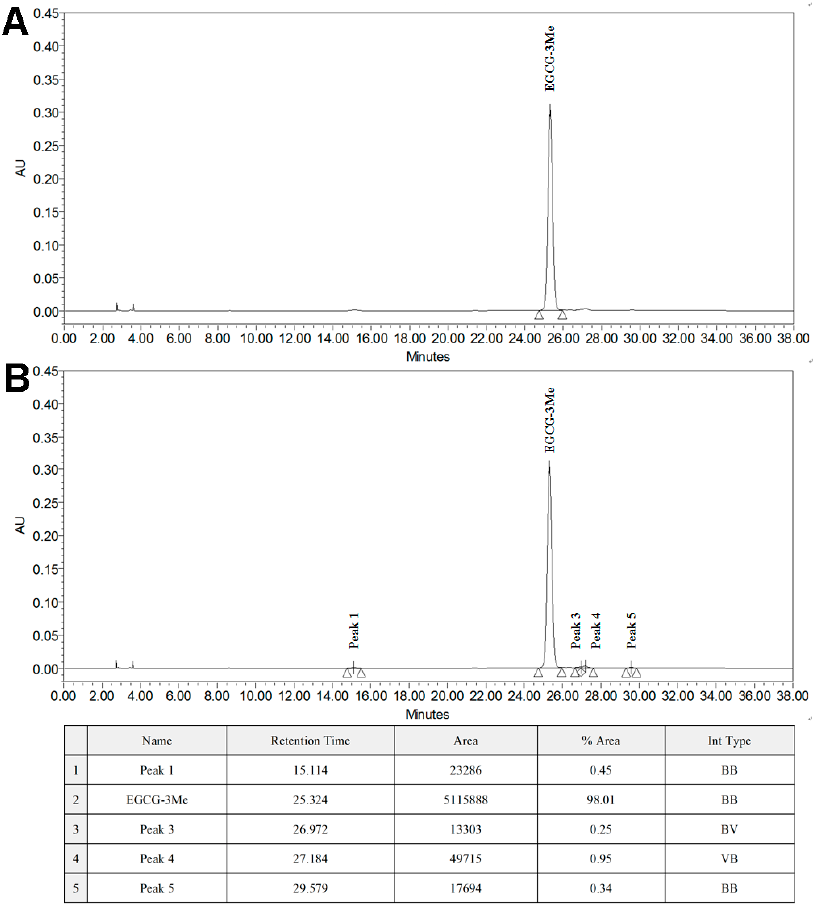
Figure 1. The HPLC chromatograms of: the EGCG-3Me standard ( A ) and the isolated compound containing EGCG-3Me ( B ). EGCG, epigallocatechin-3-gallate; EGCG-3Me, epigallocatechin-3- O -(3- O - methyl)-gallate; HPLC, high-performance liquid